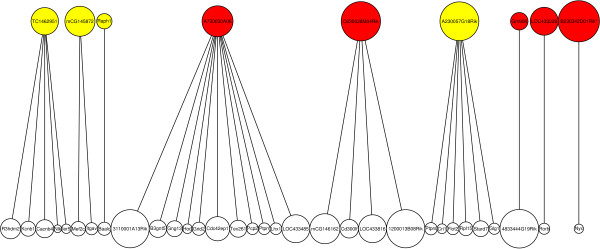
Network of brain-wide correlated expression patterns containing ncRNAs. Correlation network of 9 putative ncRNA transcripts with correlated expression over the entire brain. Red nodes represent transcripts without RNA secondary structure predictions and yellow nodes with structure predictions. These 9 transcripts are involved in 33 correlation pairs (edges, ρ>0.8).